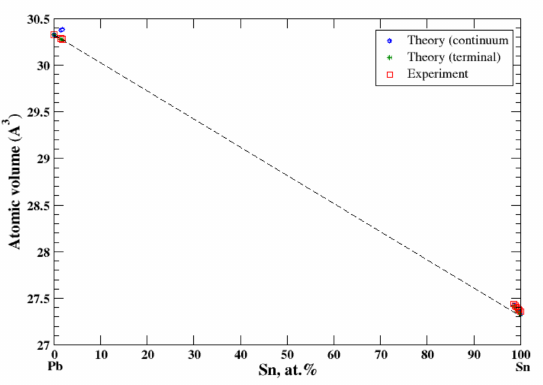
Figure 20. Atomic volume vs. concentration for Pb-Sn alloy system. The experimental data are from Ref. [16] (p. 818 and p. 862).